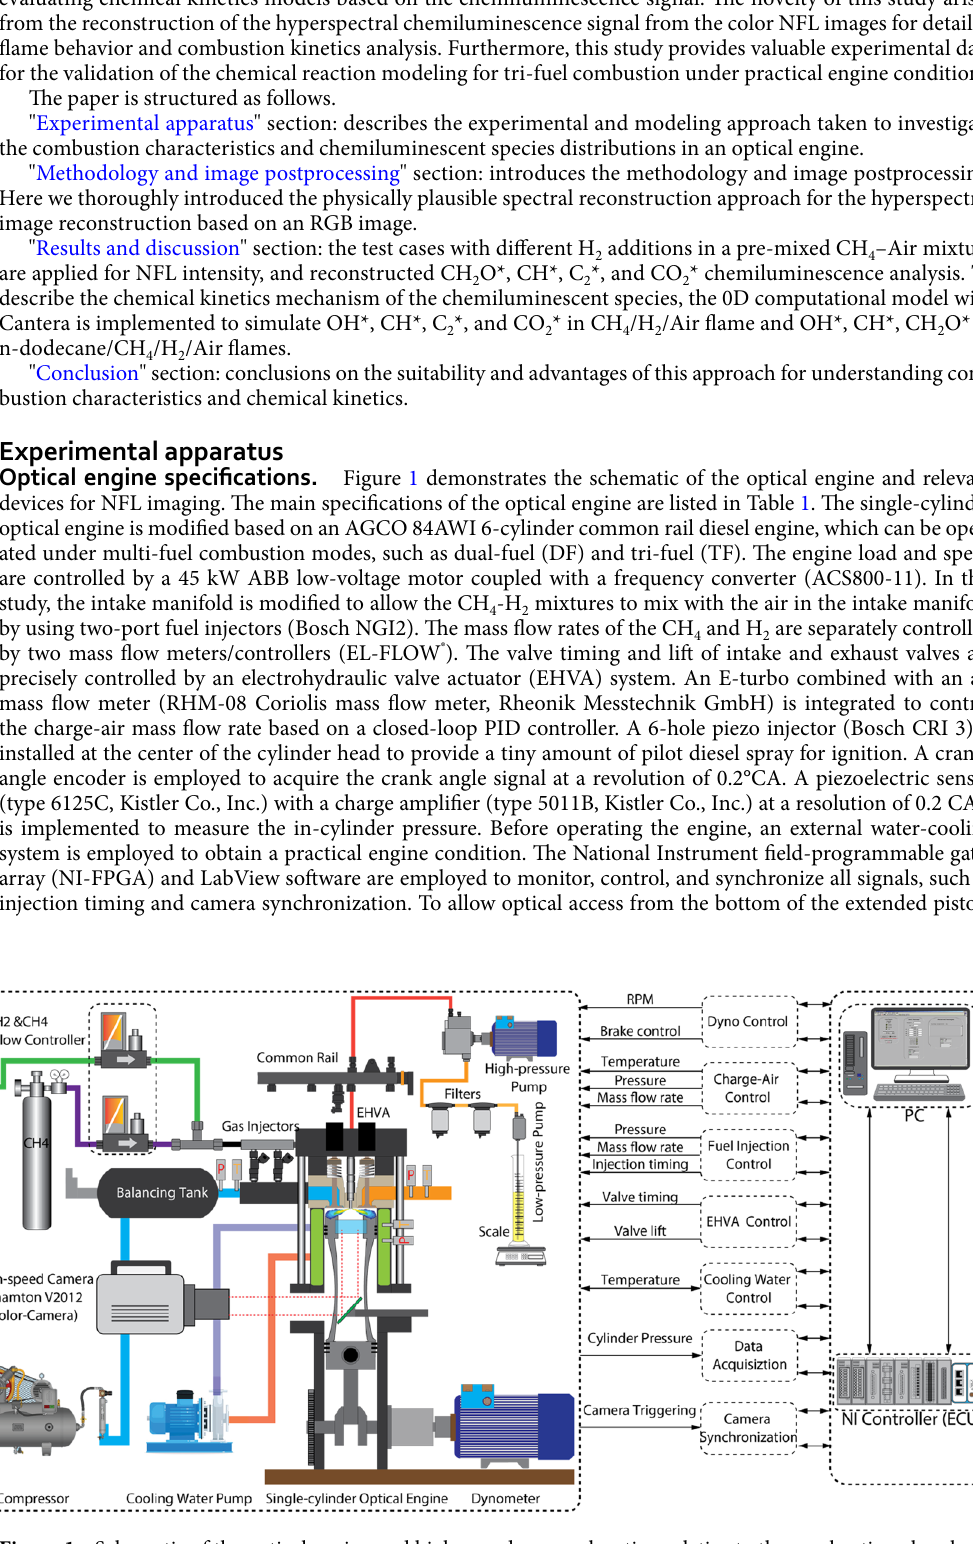
Figure 1. Schematic of the optical engine and high-speed camera location relative to the combustion